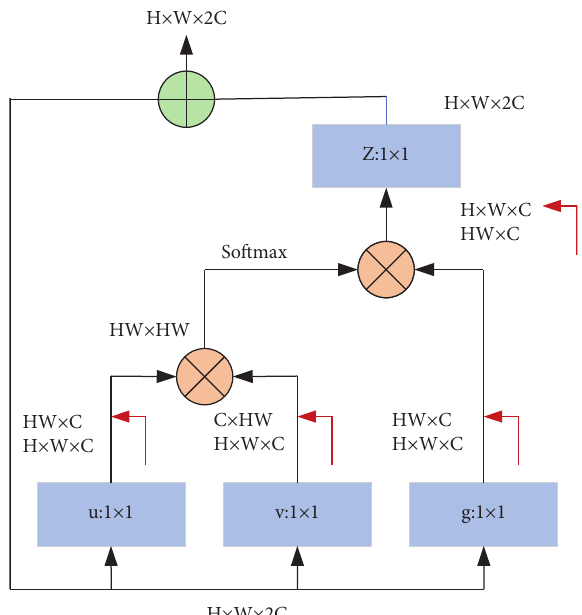
Figure 5: The framework of nonlocal block. Red solid line denotes matrix reshaping. H × W × C means C features with height H and width W , and ⊗ denotes the matrix multiplication. ⊕ denotes element-wise